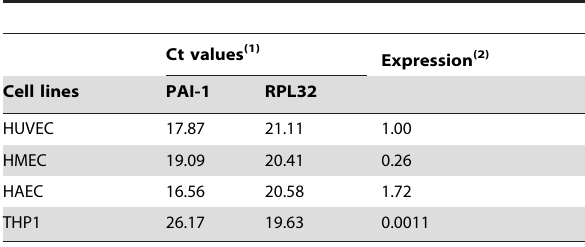
Table 1. Detection of PAI-1 mRNA by qRT-PCR in various cell